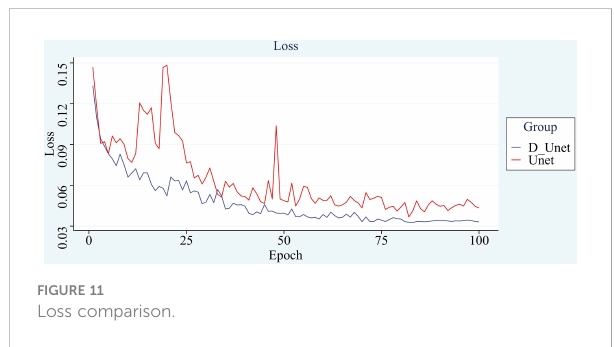
FIGURE 11 Loss comparison.